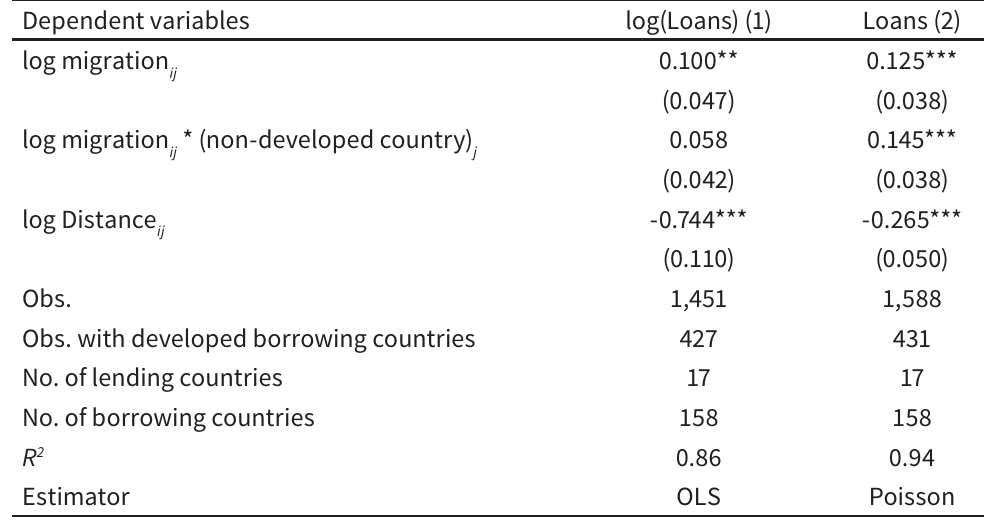
The effect of migration on loans for developed versus developing countries Dependent variables log(Loans) (1) Loans (2) log migration ij log migration * (non-developed country) ij